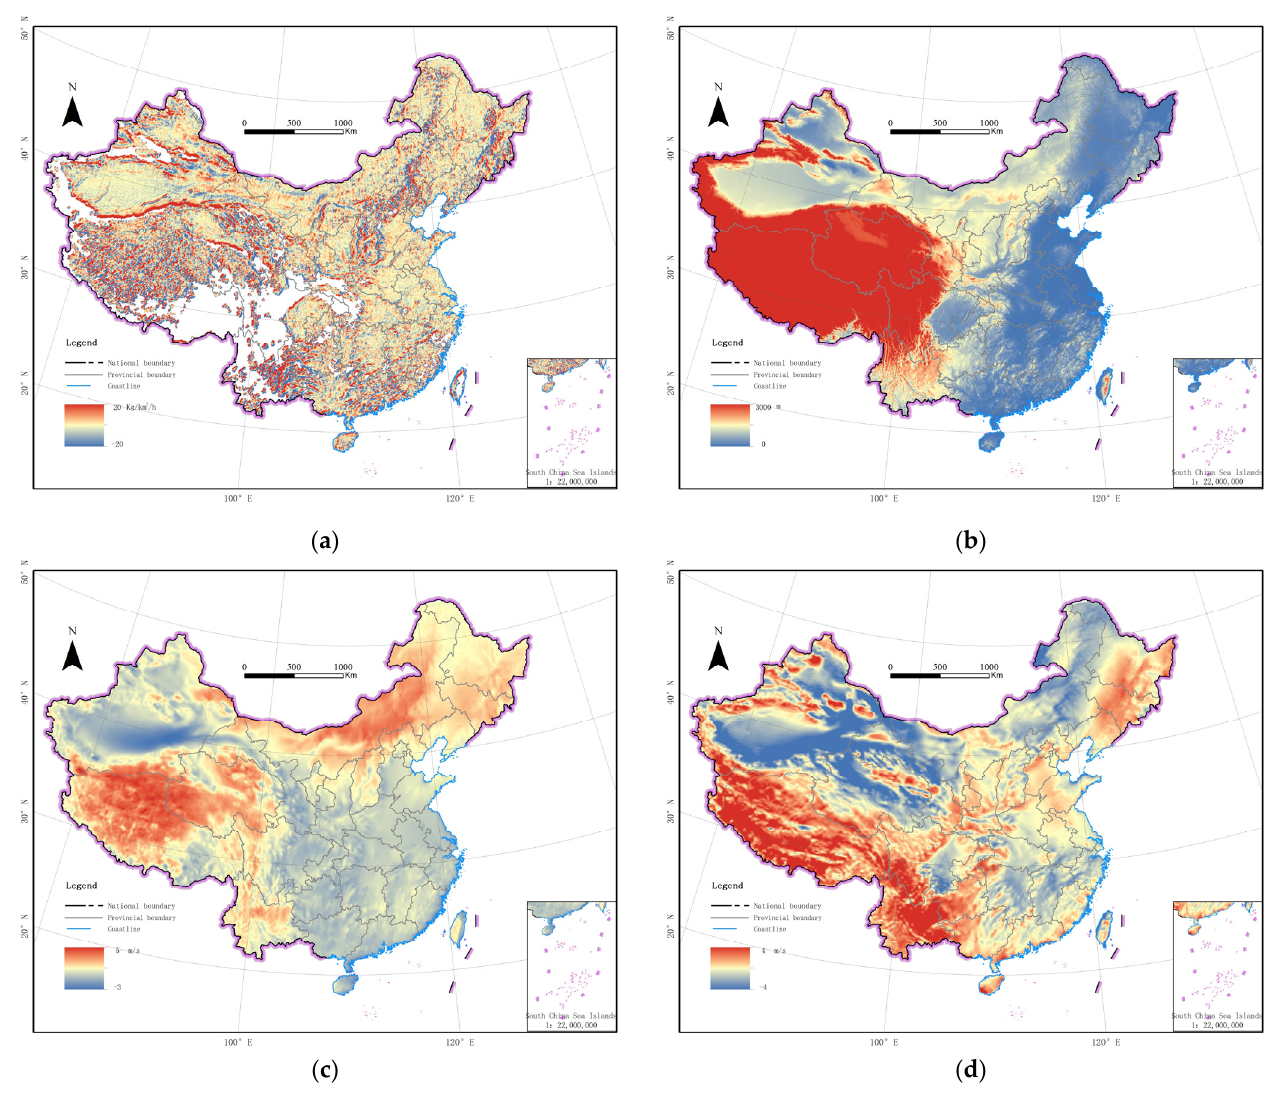
Figure 3. ( a ) Surface spatial distribution of multi-year averages CH 4 of divergence over China from January 2019 to September 2022. ( b ) The elevation map that is generated from GMTED2010 data set. ( c ) Multi-year averages distribution of eastward wind in China from 2019 to 2022. ( d ) Multi-year averages distribution of northward wind in China from 2019 to 2022.